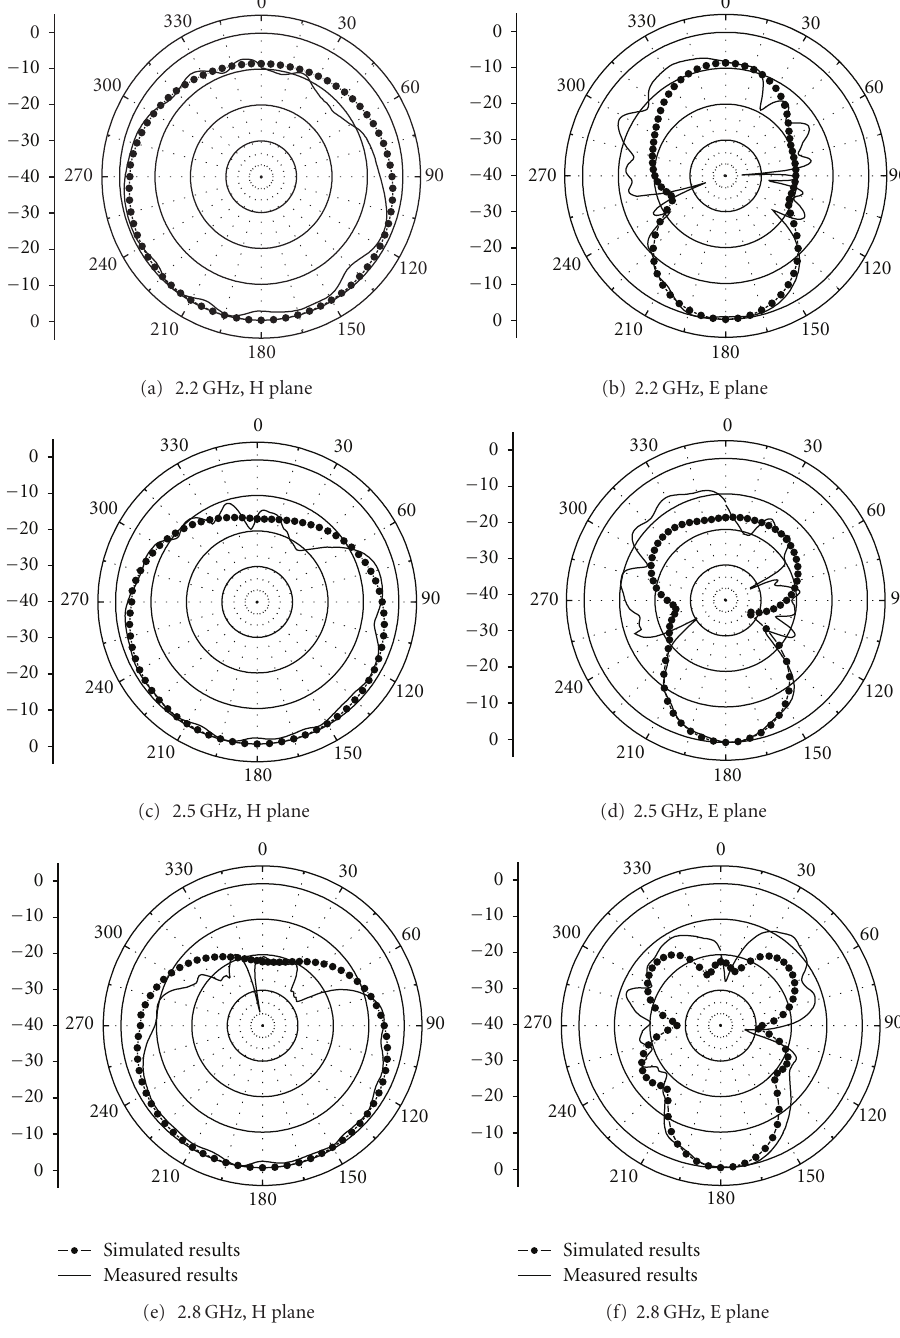
Figure 11: Simulated and experimental radiation patterns of the printed Yagi-Uda antenna